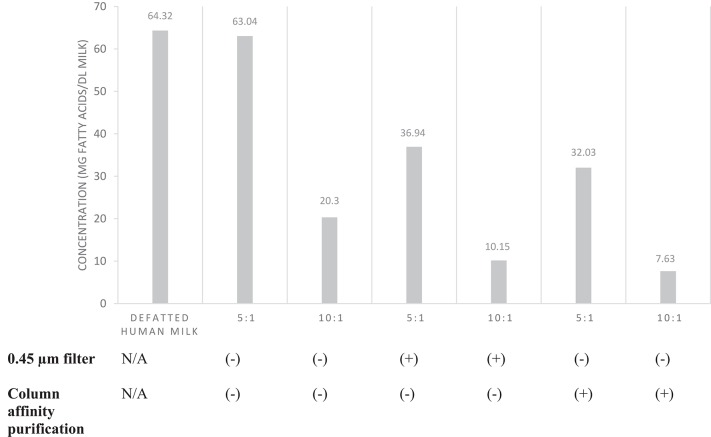
Total fatty acid concentration of EVs isolated from pooled human donor milk. The ratios represent the proportion of milk supernatant: ExoQuick-TC™ reagent used during isolation. Milk was either filtered (0.45 μm) prior to EV isolation or EVs isolated were purified by column affinity after isolation. Error bars were excluded because individual standard deviations for two technical replicates were <5% of the mean. Pooled SD = 18.78.